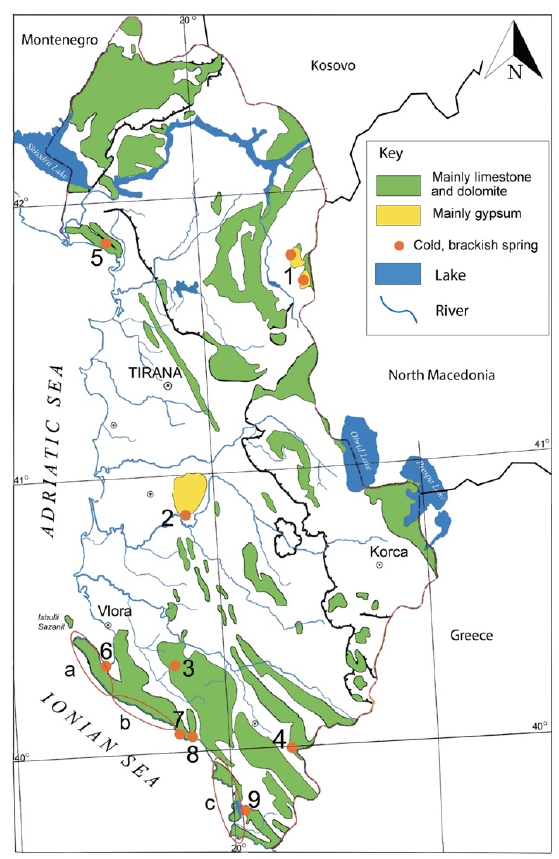
Figure 1. Location map of cold brackish springs in Albania. Springs in evaporitic deposits (halite- gypsum): 1, Korab; 2, Dumre; 3, Bashaj; 4, Glina. Springs in carbonate rocks: 5, Renci; 6, Marmiro; 7, Himare; 8, Qeparoi; 9, Butrint. Karst areas with diffusive drainage are bordered in red: ( a ) Karaburun; ( b ) Palase-Qeparoi; and ( c ) Ksamil-Gjuza (modified after